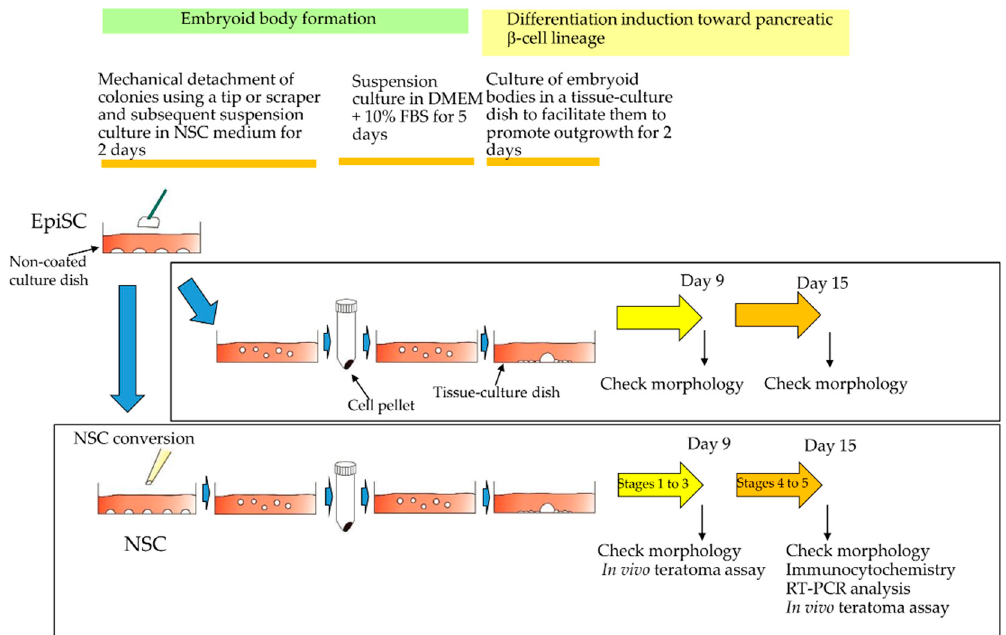
Figure 1. Schematic outline of experimental procedures to examine whether naïve stem cells (NSCs) and/or epiblast stem cells (EpiSCs) have the ability to differentiate into pancreatic β -cells. NSCs and EpiSCs were allowed to form embryoid bodies before being induced to β -cell differentiation in vitro.